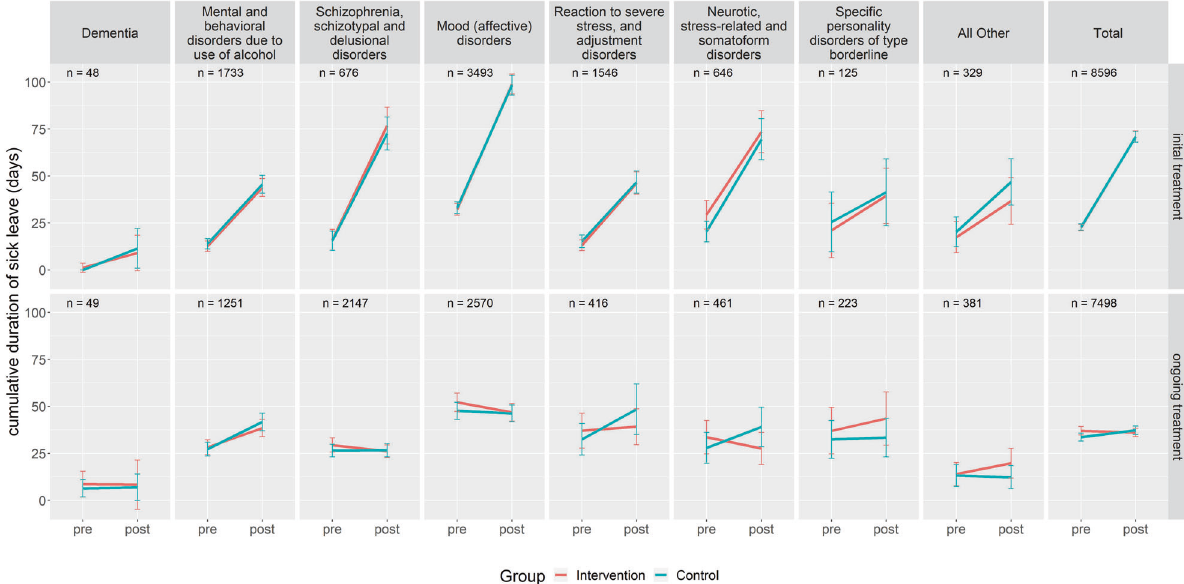
Fig. 2 Mean duration of sick leave in different clusters of psychiatric disorders (adult psychiatry). Intervention = FIT hospital, Control = hospital employing routine care; pre = 1 year prior to inclusion; post = 1 year after inclusion; Initial treatment = patients that had no contact to the psychiatric ward or PIA in the corresponding FIT or control hospital in the 2 years prior to being included into the study; Ongoing treatment = patients having at least one contact to the psychiatric ward or PIA in the corresponding FIT or control hospital in the 2 years prior to being included into the